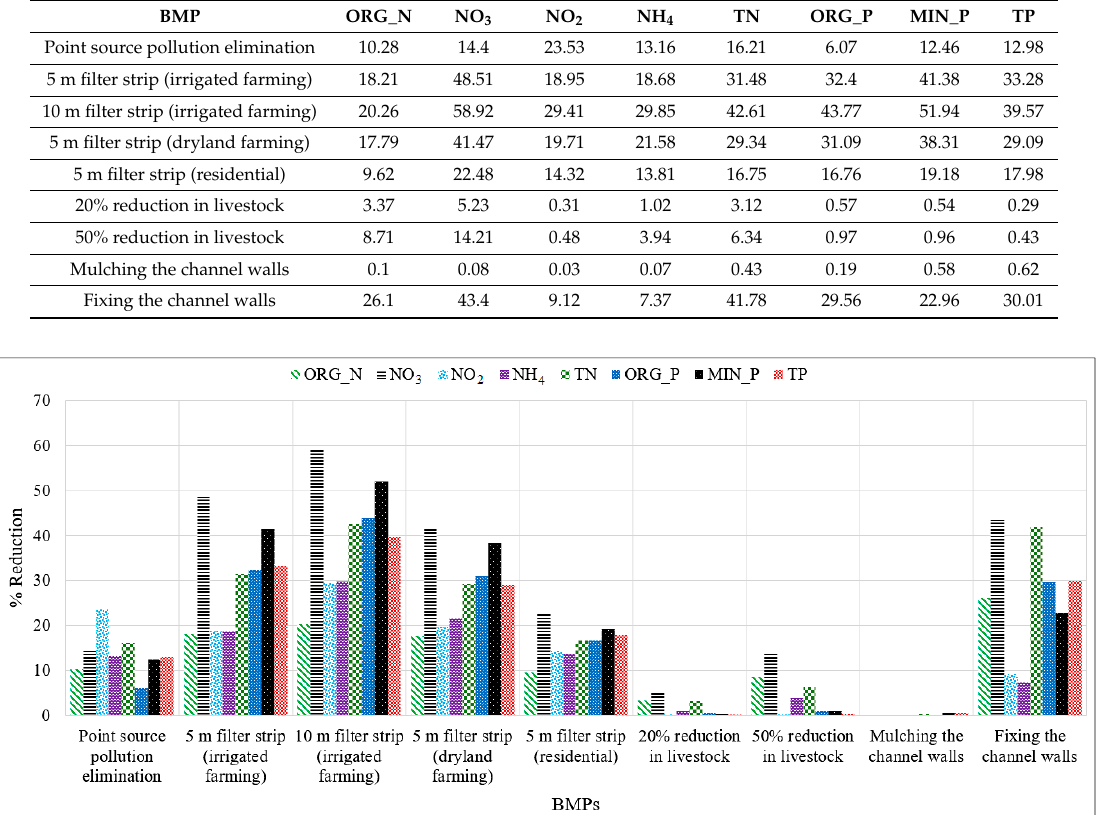
Figure 12. Reduction in pollution loads after utilizing the BMPs.